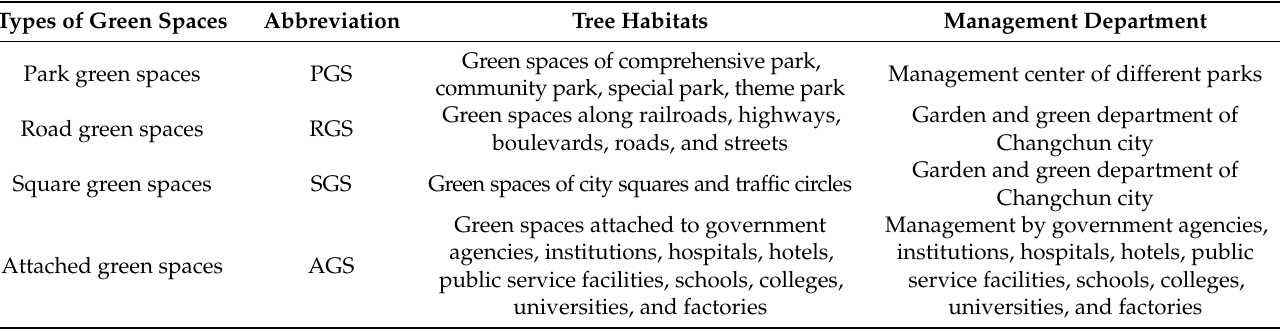
Table 1. Four tree habitats that accommodate middle-aged trees in Changchun